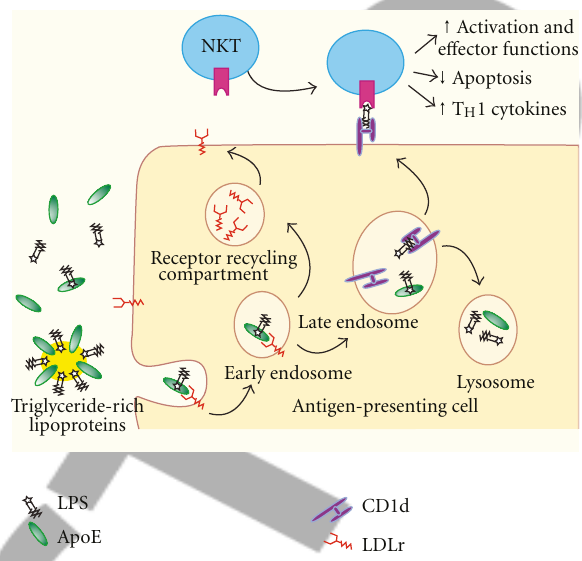
Figure 1: Proposed model of apoE-mediated lipid antigen presen- tation and NKT cell activation [89]. Pathogenic microbial lipids (i.e., lipopolysaccharide, LPS) are delivered to APCs as part of a triglyceride-rich lipoprotein or bound to apoE. The lipid complex binds to the LDLR, is internalized, and while tra ffi cked through the endosomal compartments, is processed and loaded onto CD1d for recognition by NKT